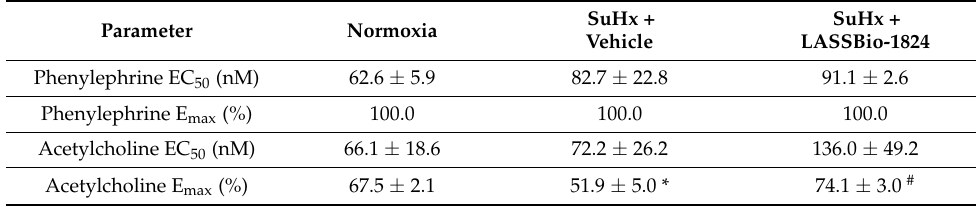
Table 2. Pulmonary artery dose–response parameters.